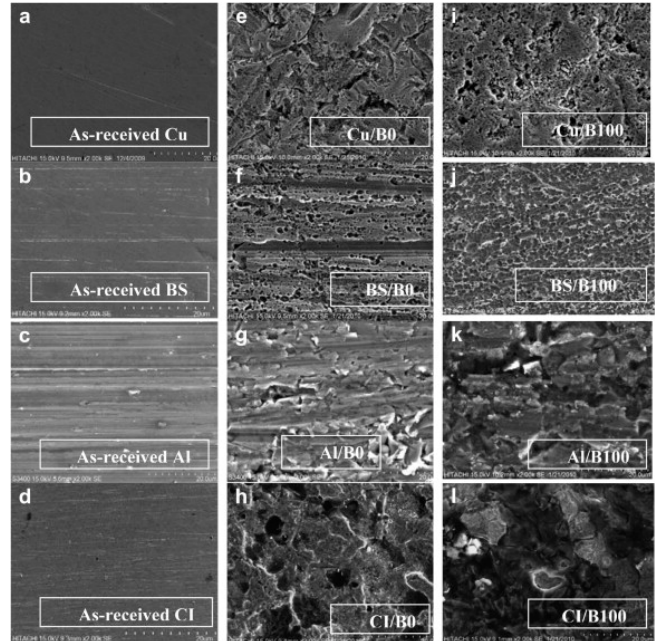
Figure 20. SEM (Scanning Electron Microscopy) micrographs of metal surfaces before and after exposure to diesel and biodiesel at room temperature for 2880 h. ( a – l ) in this figure indicate the tested metals: ( a , e , i ) Cu, ( b , f , j ) BS, ( c , g , k ) Al and ( d , h , l ) Cl [149].